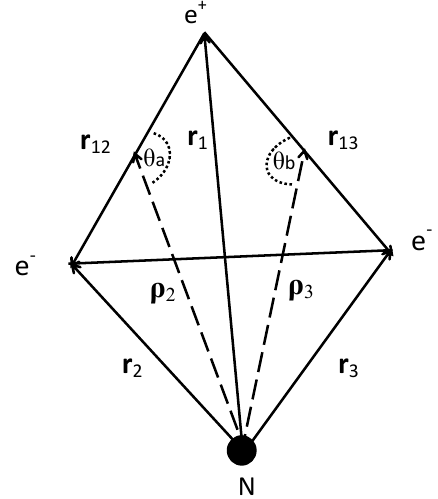
Figure A1. The positron–helium coordinate